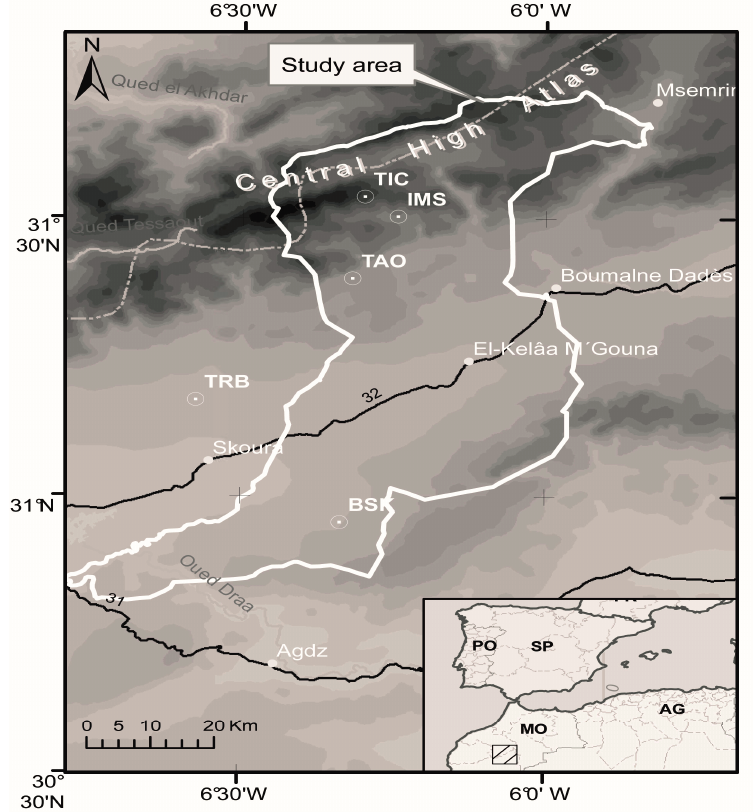
Figure 1. Study area located in Southern Morocco. The boundary of our research area is given in bold white. The locations of the measurement sites are indicated with white circles (TIC: Tichki, IMS: Ameskar, TAO: Taoujgalt, TRB: Trab Labied, BSK: Bou